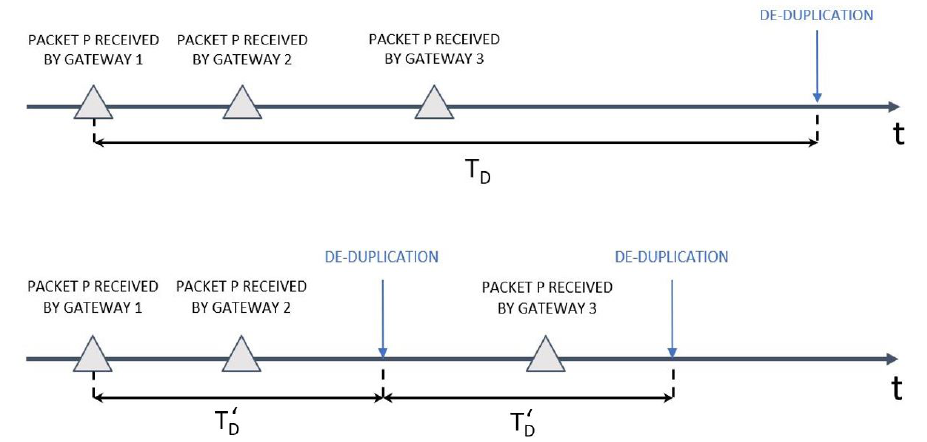
Figure 15. Scheme of the de-duplication behaviour in function of the time. In the upper scheme is represented only one de-duplication window T D while in the scheme below has two de-duplication windows of time T (cid:48) . At the end of each de-duplication window the network sever performs the ms. D